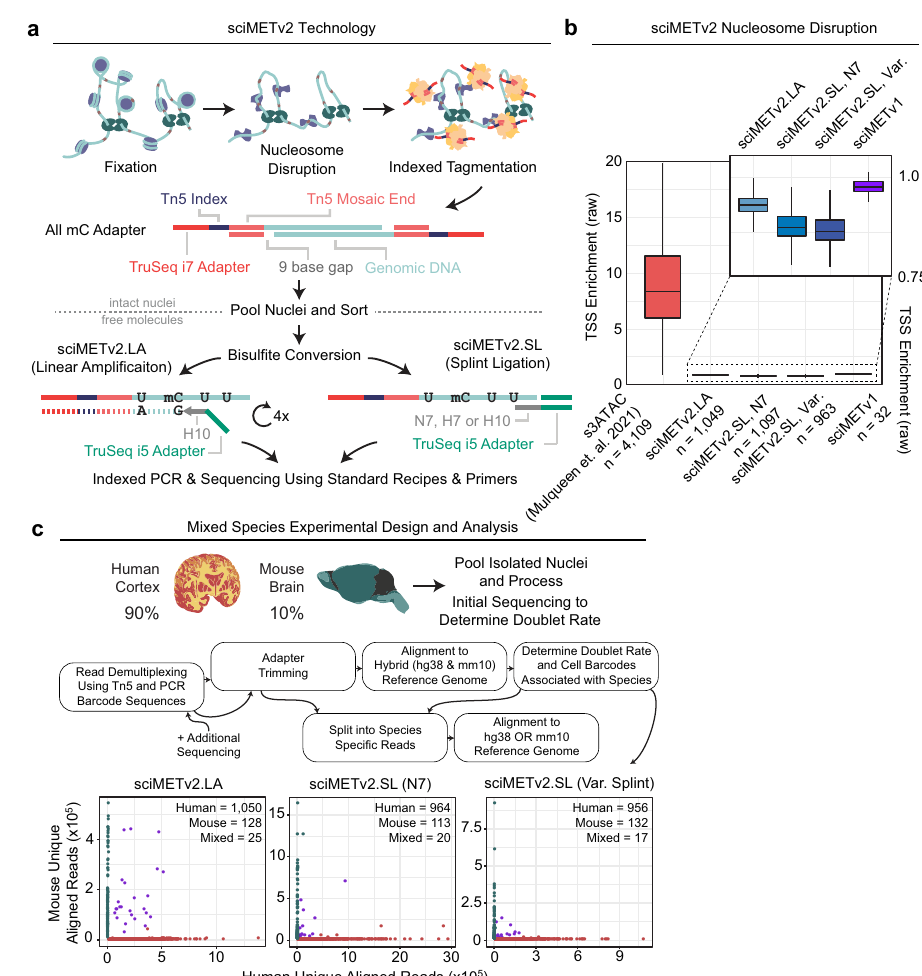
Fig.1|sciMETv2methodandexperimentaldesign.a Molecularwork fl owforthe sciMETv2technologies. b Nucleosomedisruptioneffectivenessasmeasuredbyraw transcription start site (TSS) enrichment. Tagmentation of intact nuclei preserves TSSenrichmentwhichisablatedbynucleosomedisruptioninsciMETassays.Forall boxplots, boxesindicate median, 25thand 75thpercentiles withmin and maxlines